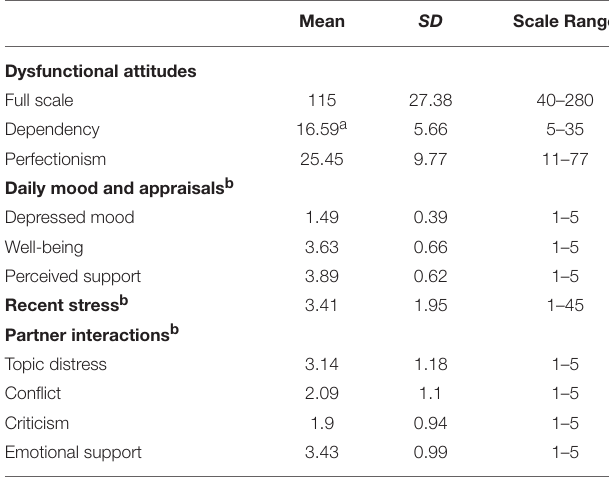
TABLE 1 | Means, standard deviations, and ranges for dysfunctional attitudes, daily moods and appraisals, recent stress, and characteristics of partner interactions.